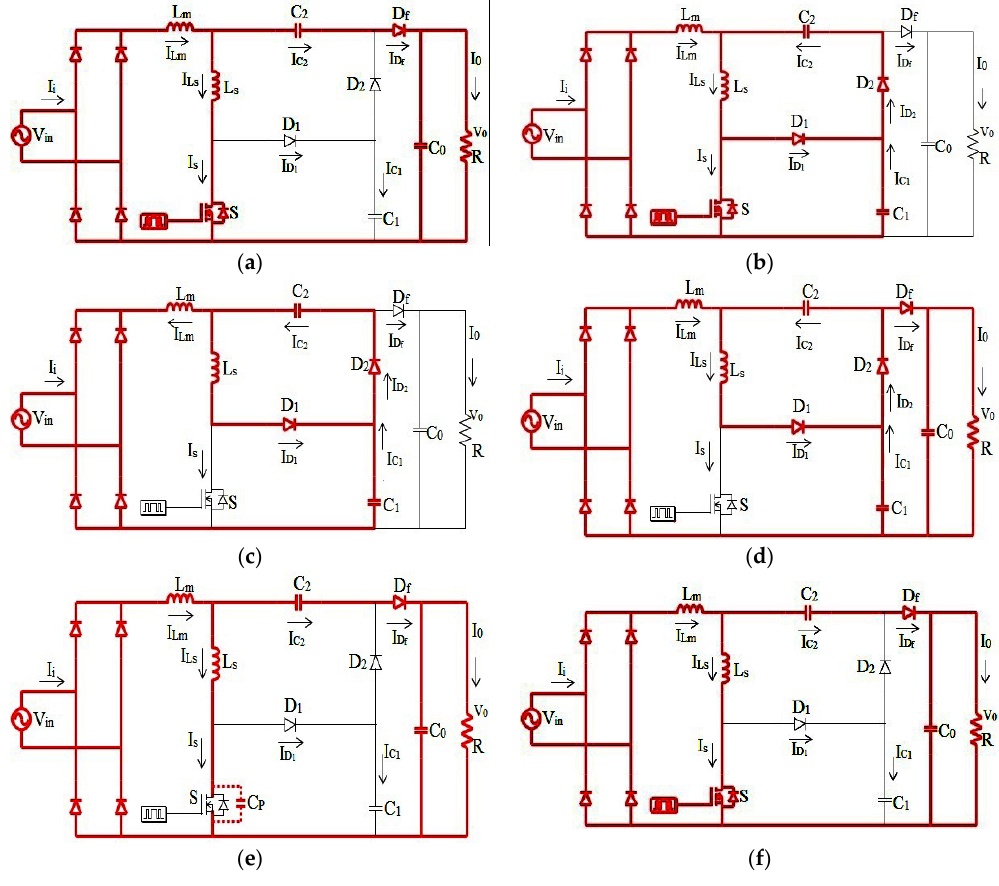
Figure 3. Operation modes of the proposed converter in a switching cycle: ( a ) mode 1; ( b ) mode 2; ( c ) mode 3; ( d ) mode 4; ( e ) mode 5; ( f ) mode 6.